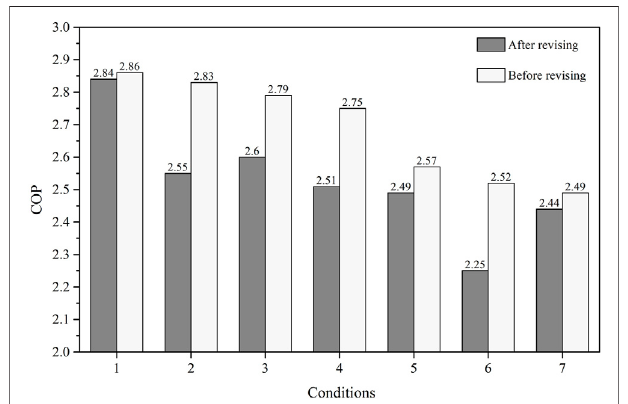
FIGURE 15 | System COP under different conditions after excluding the in fl uence of the outdoor